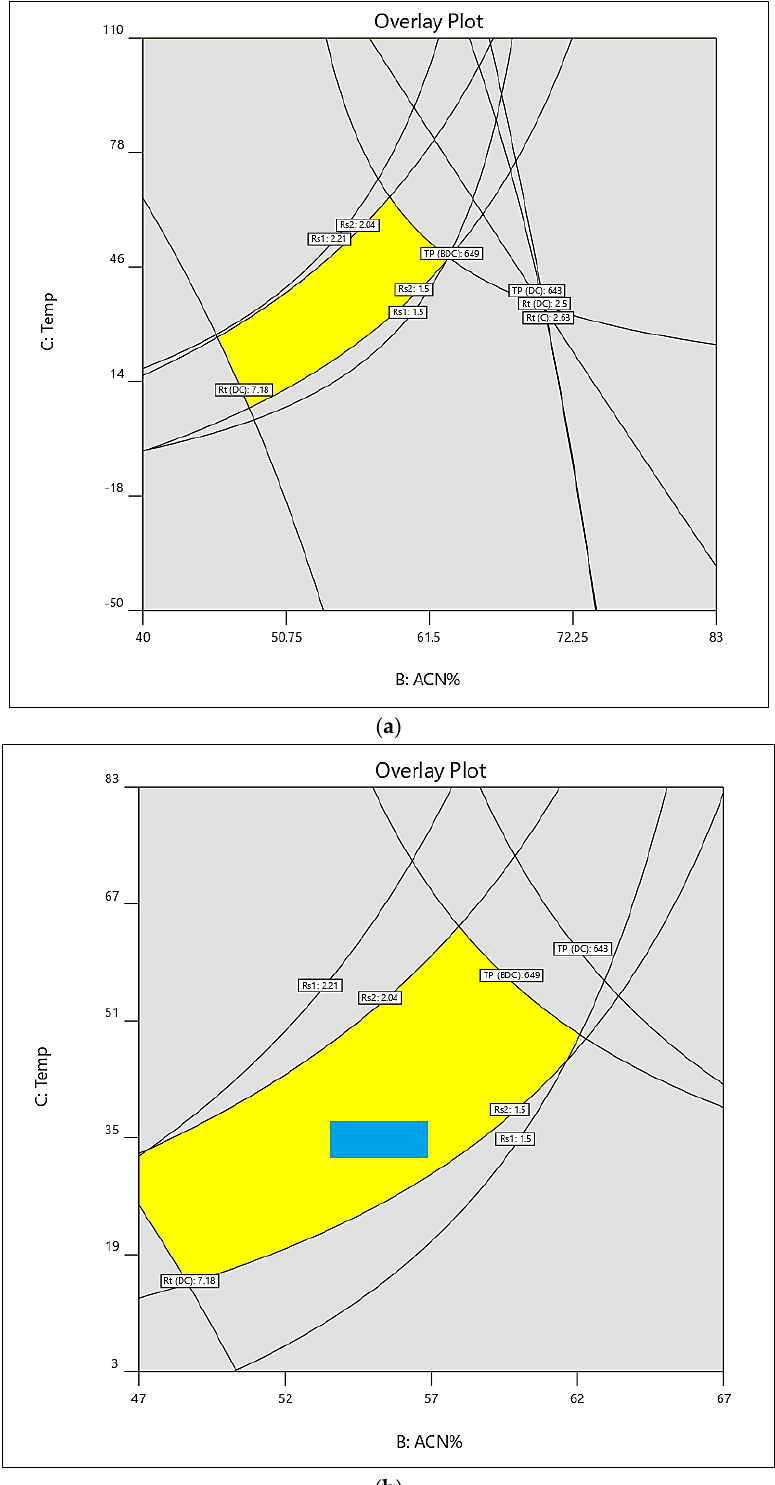
Figure 4. ( a ) Design space overlay incorporating the CMPs. ( b ) Design space generated for robust chromatography for curcuminoids.